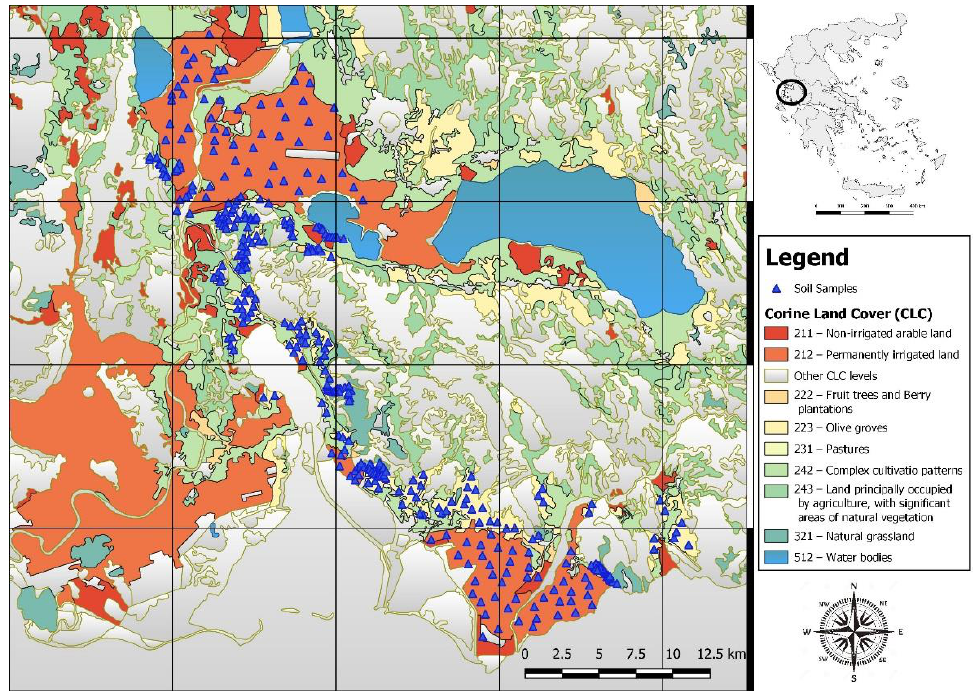
Figure 1. The investigated area, located in the Aitoloakarnania prefecture, Western Greece.